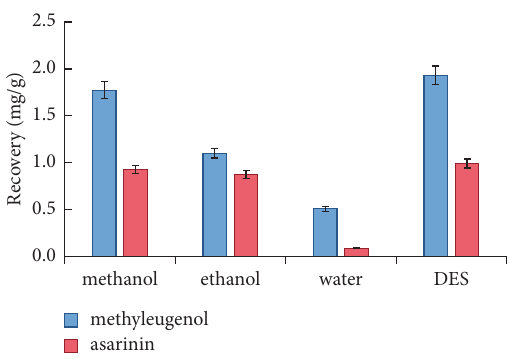
Figure 10: Comparison of other extraction